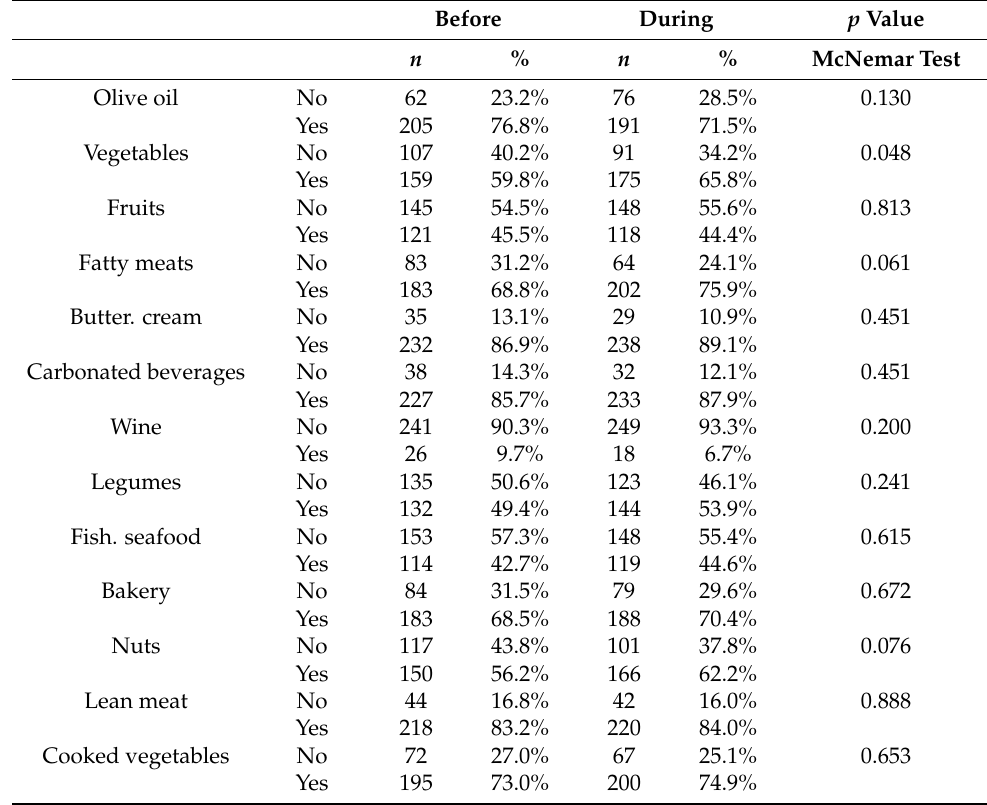
Table 4. Changes in eating habits before and during the COVID-19